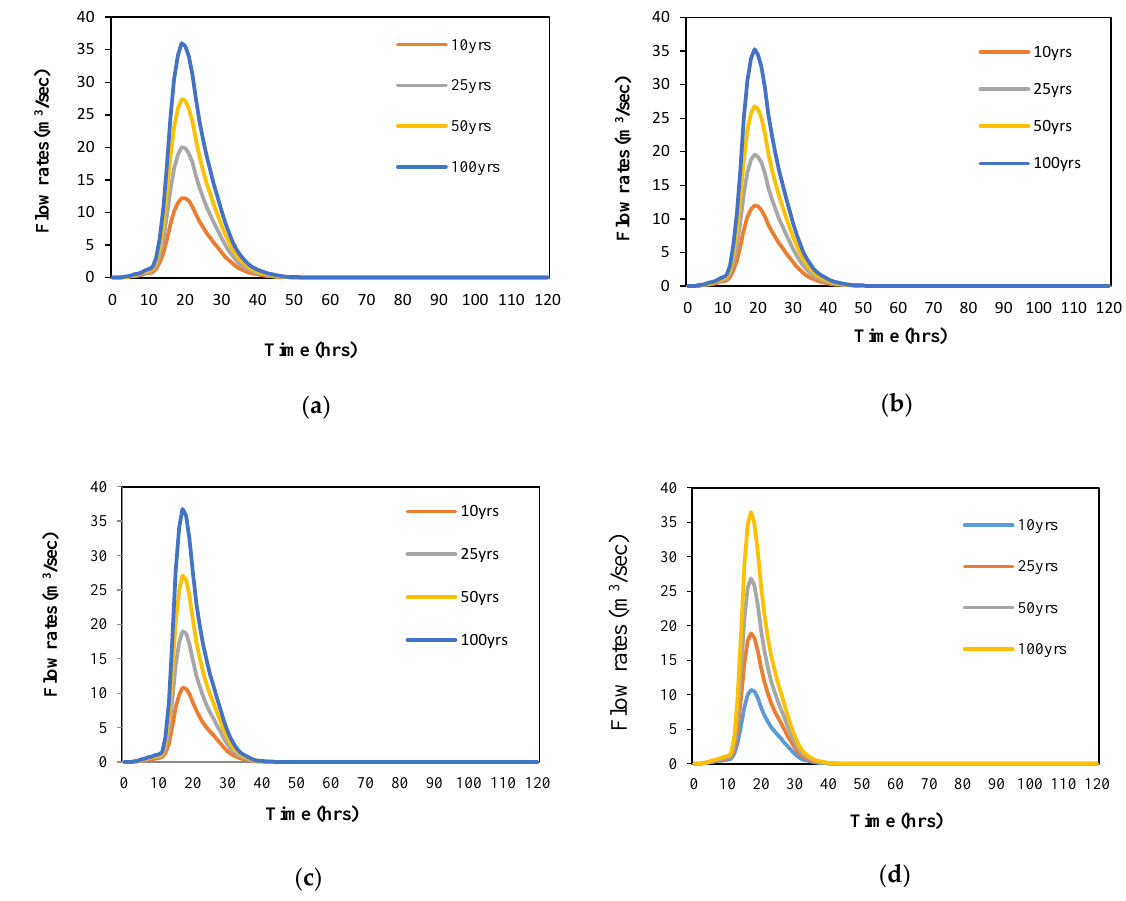
Figure 10. Design hydrogrpahs generated from HEC, ( a ) runoff from 30 m DEM (Al Khaleej); ( b ) runoff from actual survey DEM (Al Khaleej); ( c ) runoff from 30 m DEM (Al Naqaa) ; ( d ) runoff from actual survey DEM (Al Naqaa). Table 4. HEC- HMS results for Al Khaleej and Al Naqaa catchments using two source s of DEM. Return